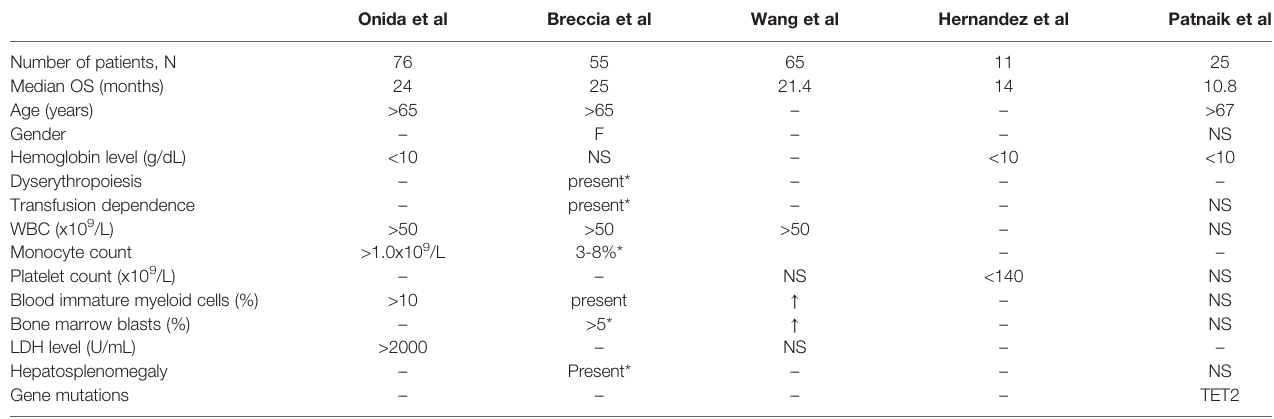
TABLE 4 | Factors correlated with lower overall survival in patients with atypical chronic myelogenous leukemia, BCR/ABL1